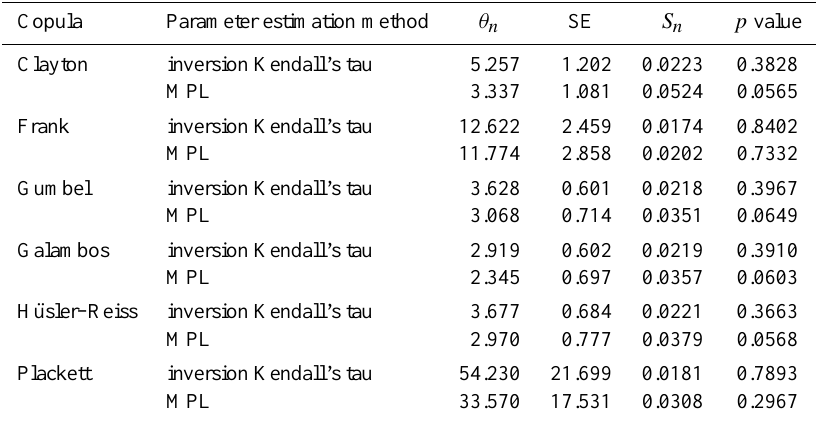
Table 4. Estimated value of the copula parameter ( θ n ), copula parameter standard error (SE), Cram´er-von Mises goodness-of-fit test ( S n ) and p value calculated based on N =10000 parametric bootstrap samples, according to the parameter estimation method.